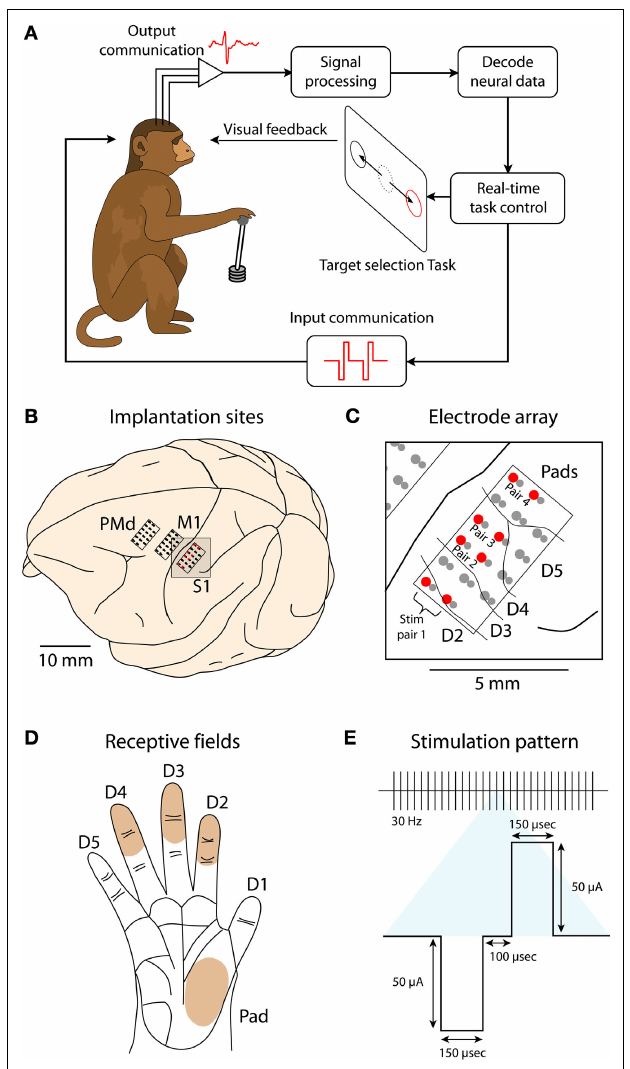
FIGURE 1 | Schematic of the experimental paradigm. (A) A monkey is seated in front of a video screen to which the images of a cursor and visual targets are projected. The animal acquires targets with the cursor either manually using a joystick or directly by the activity of populations of motor-cortical cells. If more than one target is presented, reach direction is instructed by joystick vibration or artifi cial somatosensation delivered via ICMS of primary somatosensory cortex (S1). (B) Implanted sites in Monkey 1. The monkey was implanted with microwire arrays in two motor-cortical areas (dorsal premotor, PMd, and primary motor, M1) and a primary somatosensory area (S1). (C) Zoomed-in region focuses on the S1 implant. Red circles indicate electrode pairs used for ICMS. Lines between electrodes indicate receptive fi eld boundaries. The electrode grid covered the representation of digits D2–D5 and hand pads. (D) Illustration of the monkey palm with the shaded regions indicating the receptive fi elds for the electrode pairs used for ICMS. (E) Parameters of an ICMS pulse